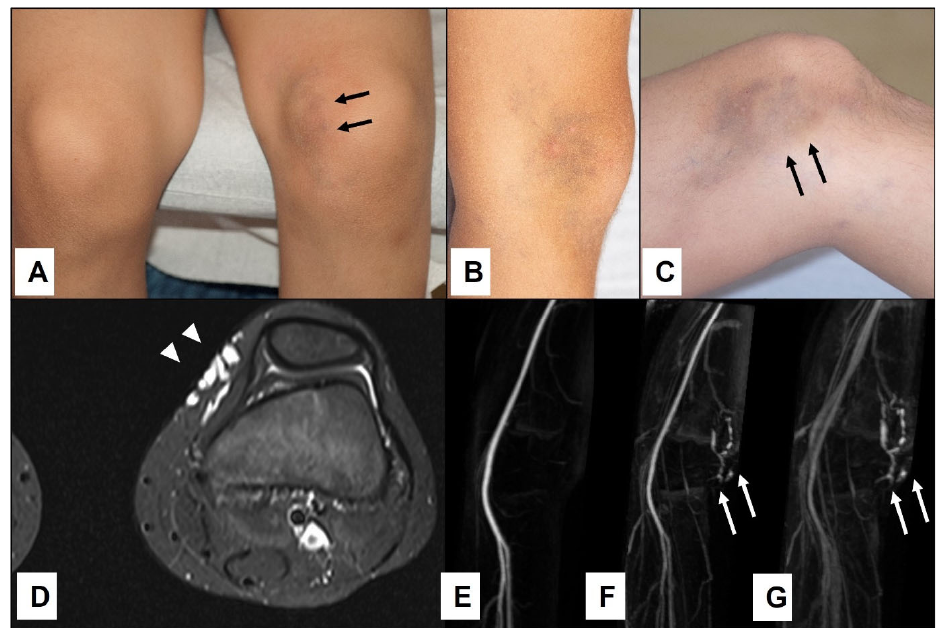
Figure 2. An 11-year-old boy presented with bluish swelling medially on the left knee ( A ): white (arrowheads). The lesion was compressible and would drain and flatten with the elevation of the leg indicating clinically the venous malformation ( B , C )—(white arrowheads). MRI showed the exact location and extension of tubular-cystic venous malformation ( D )—(white arrowheads), which filled with contrast material in the venous phase of the MR angiography ( E – G )—(white arrows), confirming the clinical diagnosis. The patient was referred to sclerotherapy.